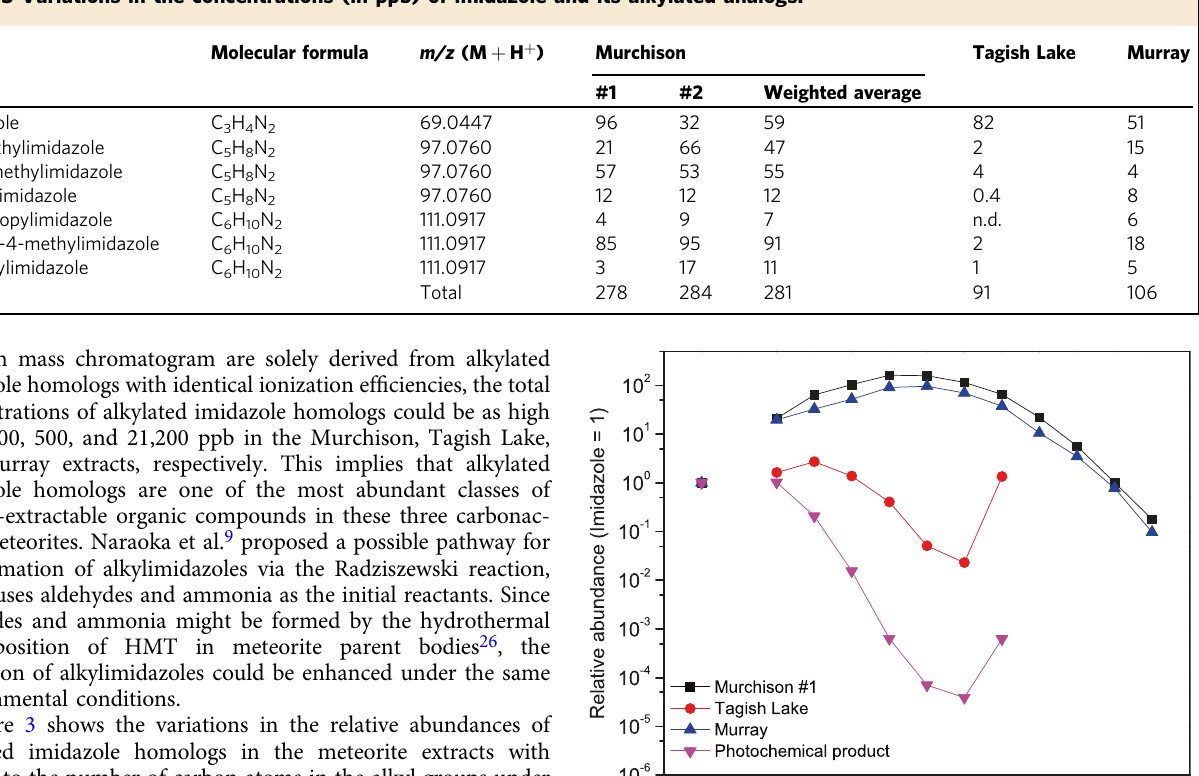
Table 3 Variations in the concentrations (in ppb) of imidazole and its alkylated analogs.